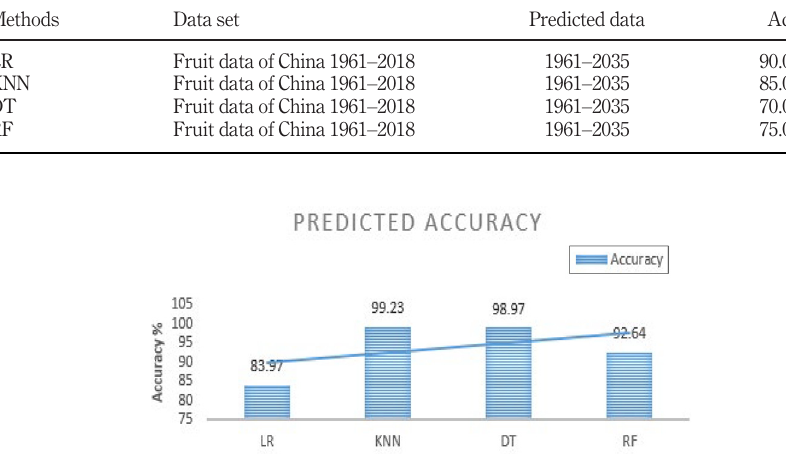
Figure 8. Graph of